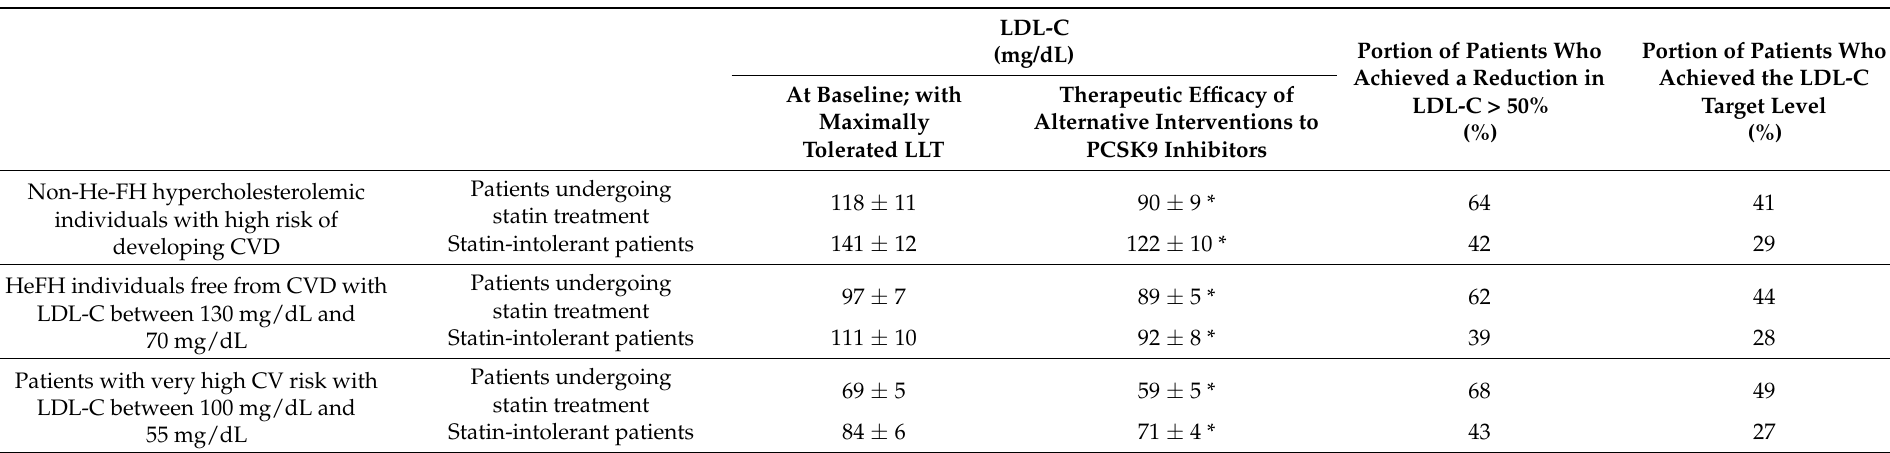
Table 2. Therapeutic achievement after 6 months of alternative interventions to PCSK9 inhibitors, in patients who were not allowed access to treatment with PCSK9 inhibitors based on national reimbursement rules issued by AIFA before June